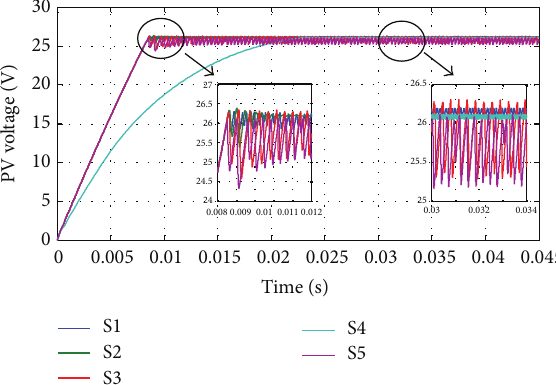
Figure 15: PV power at irradiation of 1000W/m 2 and 25 ∘ C.